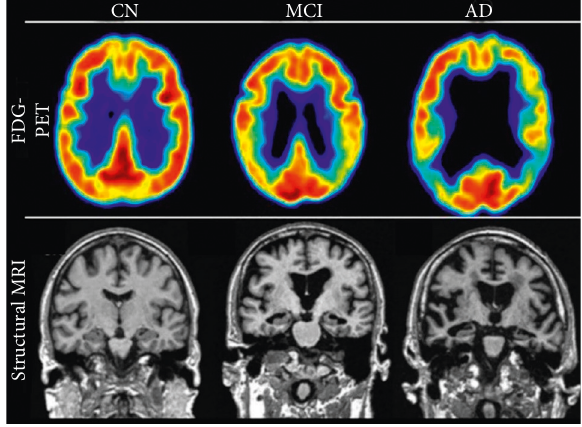
Figure 4: Input image dataset of Asim and coresearchers (FDG � fluorodeoxyglucose) [17].